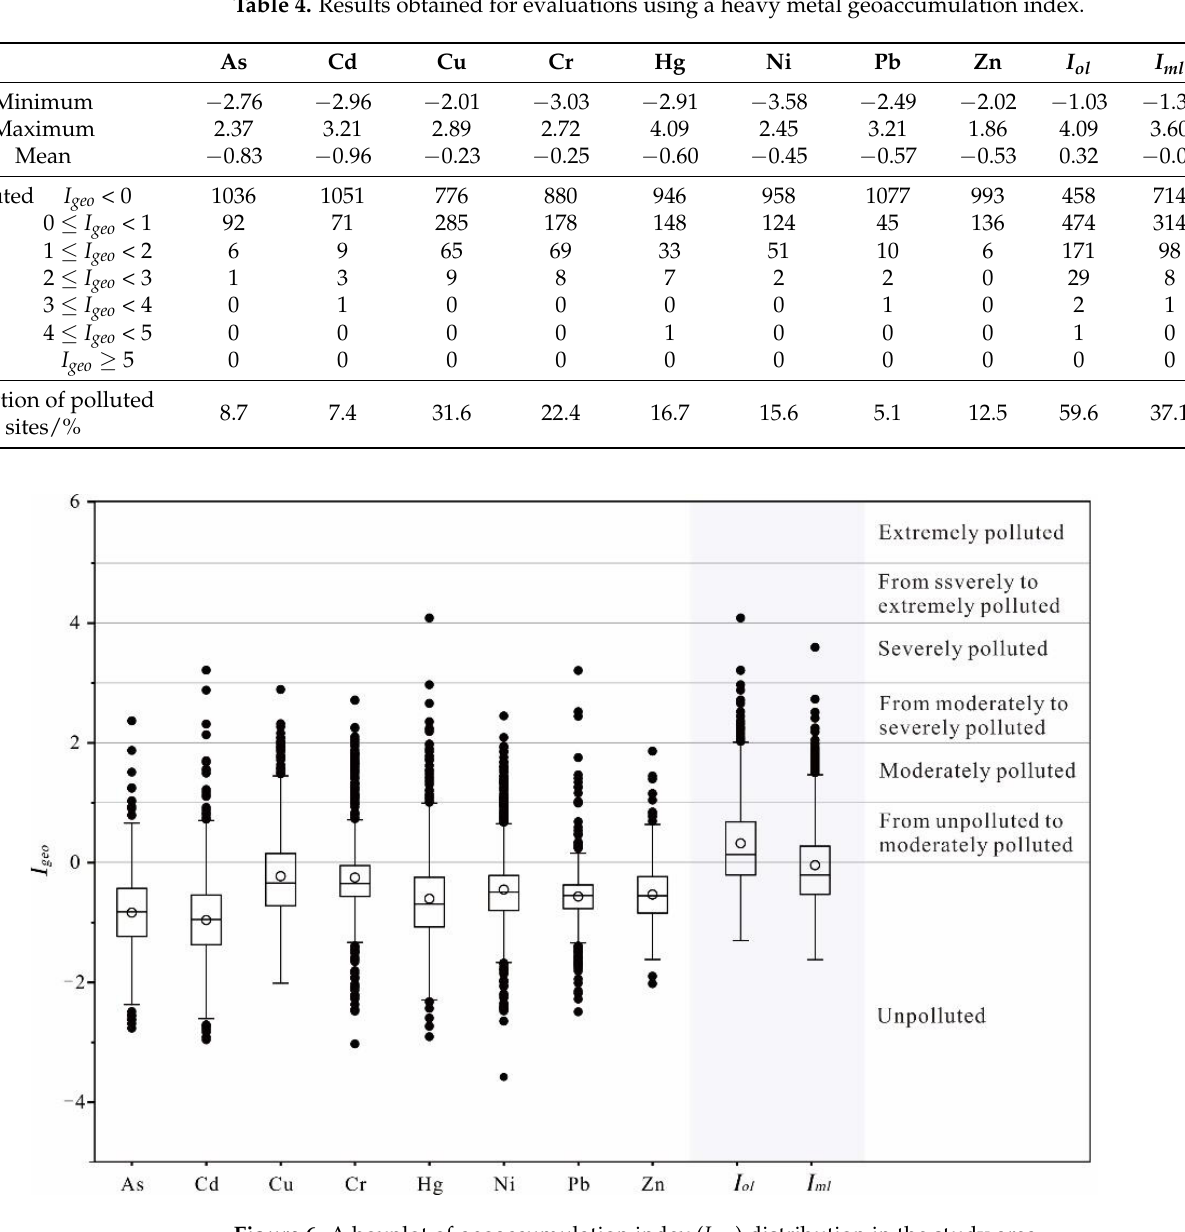
geo ) distribution in the study